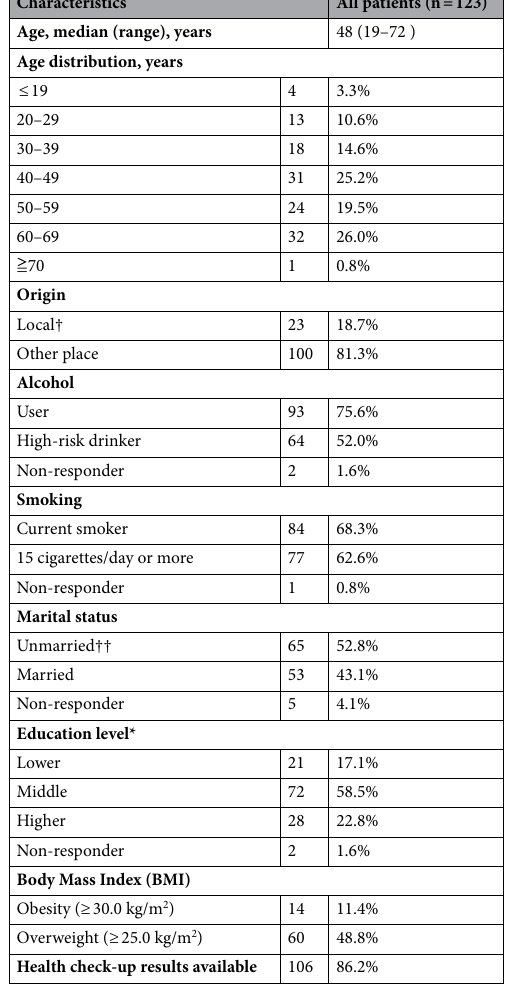
Table 1. Baseline characteristics among 123 healthy male decontamination workers. † Locals were defined as workers who originated from Hamadori or Nakadori region in Fukushima Prefecture. †† Persons who divorced or were never married. *Education level was categorized into three levels: lower, ≤ 9 years, i.e., junior high school; middle, 10–12 years, i.e., high school and technical college; and higher, ≥ 13 years, i.e., university degree.